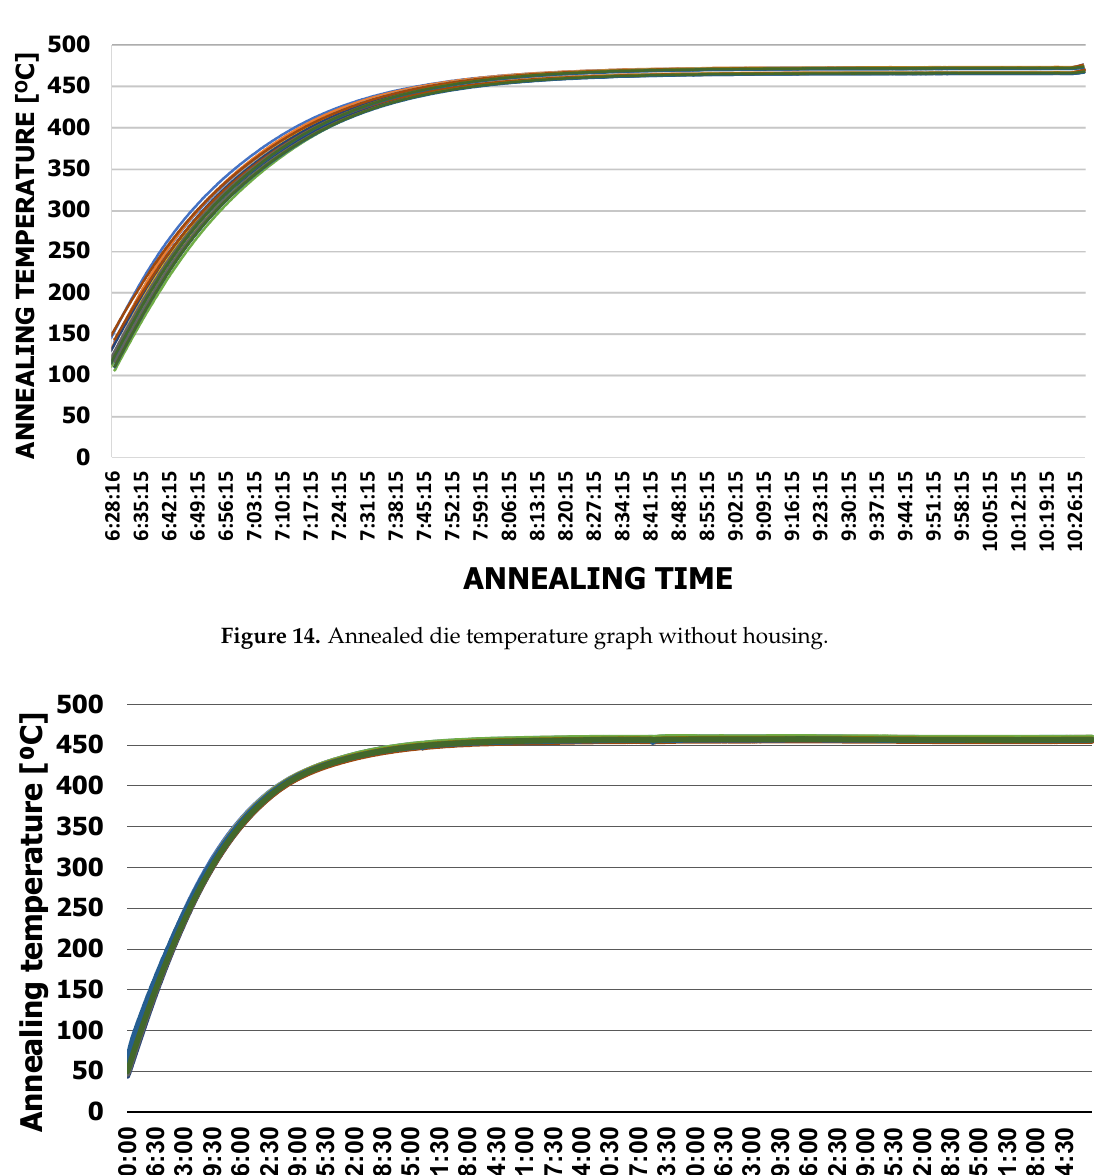
Figure 13. Dies with marked places of thermocouples that measure the achieved temperature during annealing at 460 °C. ( a ) first example of die; ( b ) second exaple of die.